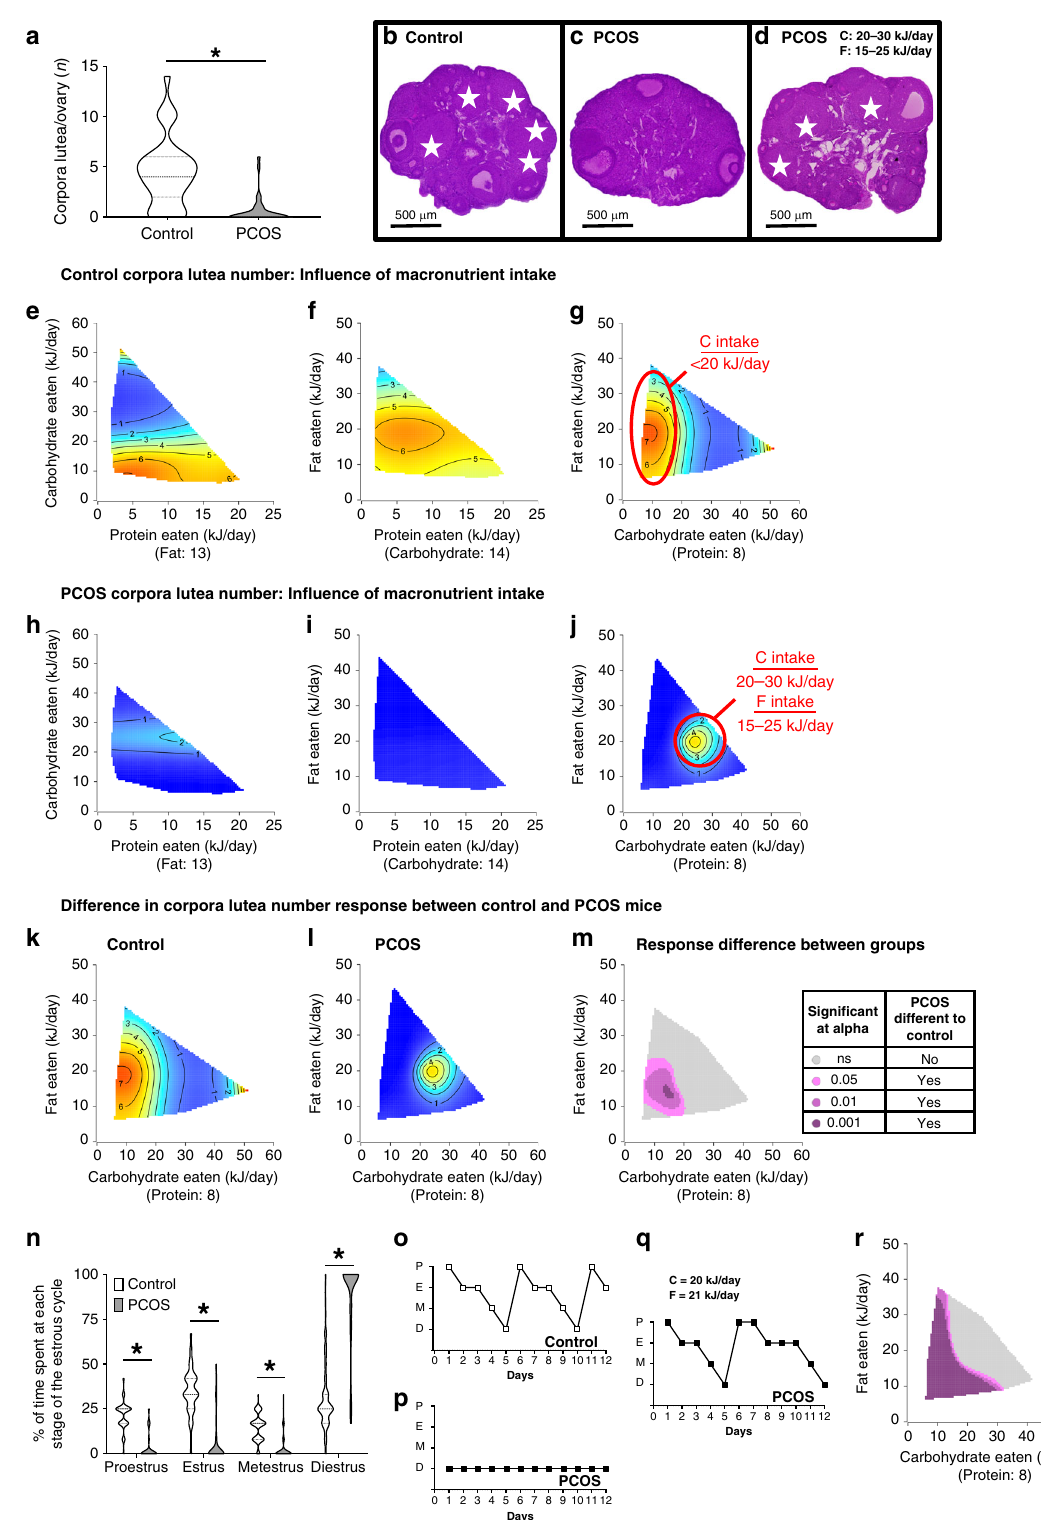
present within the ovaries of a subset (8/35) of PCOS mice (Fig. 1d). We used response surfaces to detail the effects of all three macronutrients on CL response. All control mice ovulated and displayed maximal CL numbers on dietary intakes of <20 kJ/ day C and 10 – 25 kJ/day F, shown by the area circled in red (CxF P = 0.033; Fig. 1g and Supplementary Table 2). The majority (77%, 27/35) of PCOS females analyzed were anovulatory